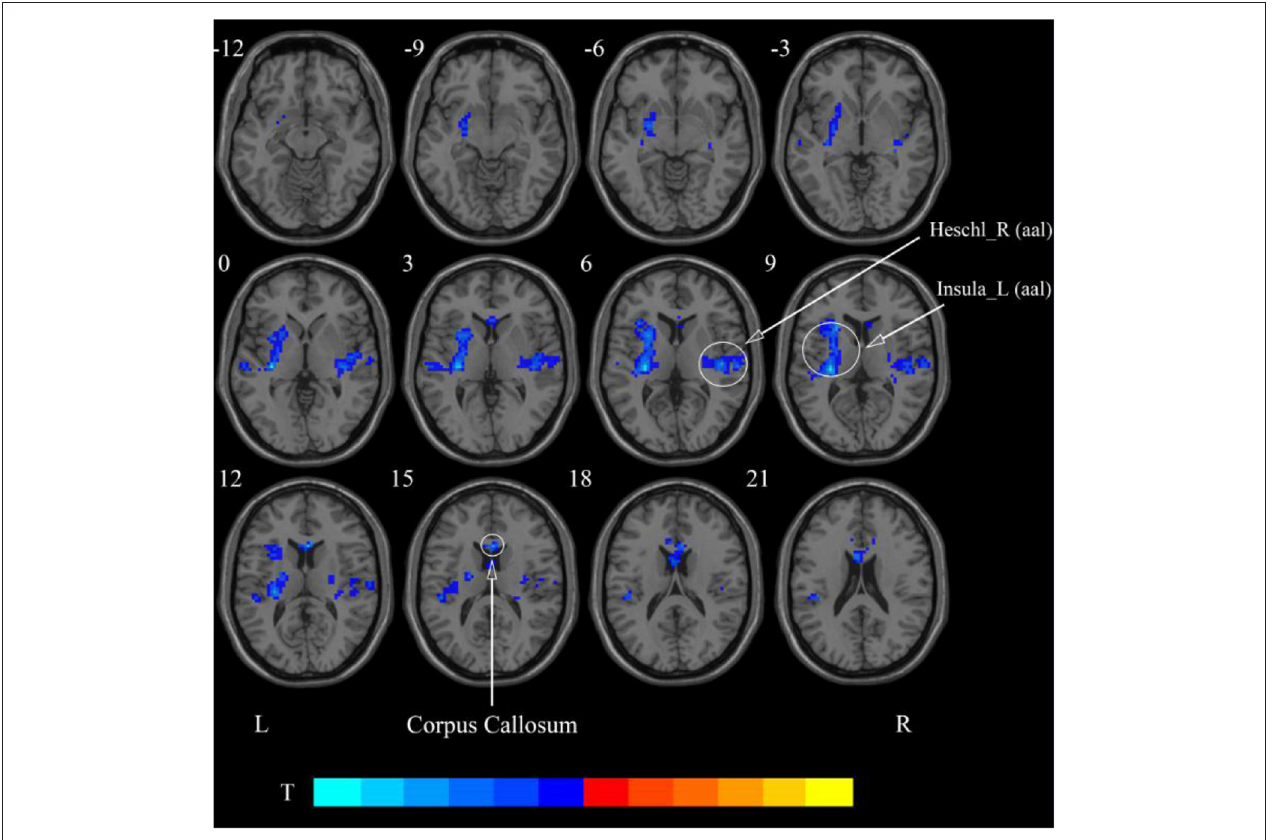
FIGURE 6 | Statistical maps showing ReHo change pre- and post-rTMS in the classical frequency band. Cool colors showing ReHo decreased after rTMS p < 0.05.